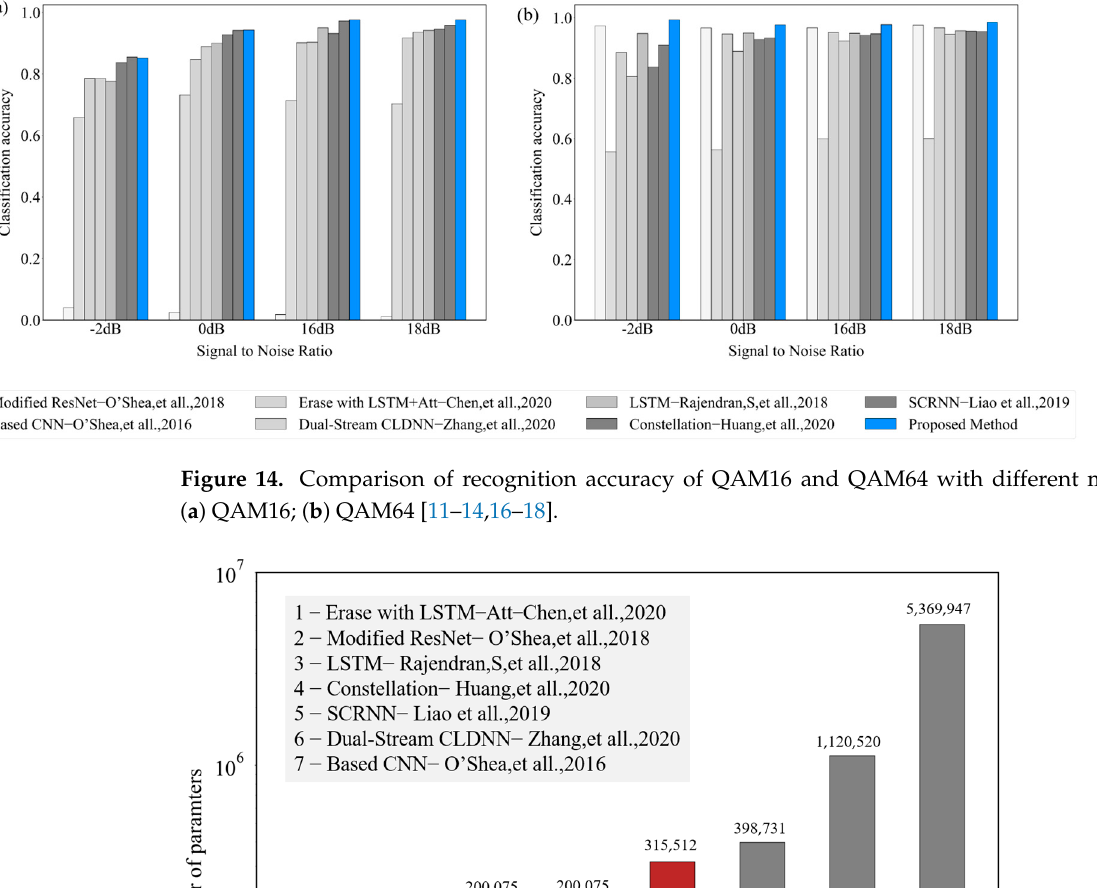
Figure 13. Comparison of recognition accuracy of models under different SNRs [11–14,16–18].